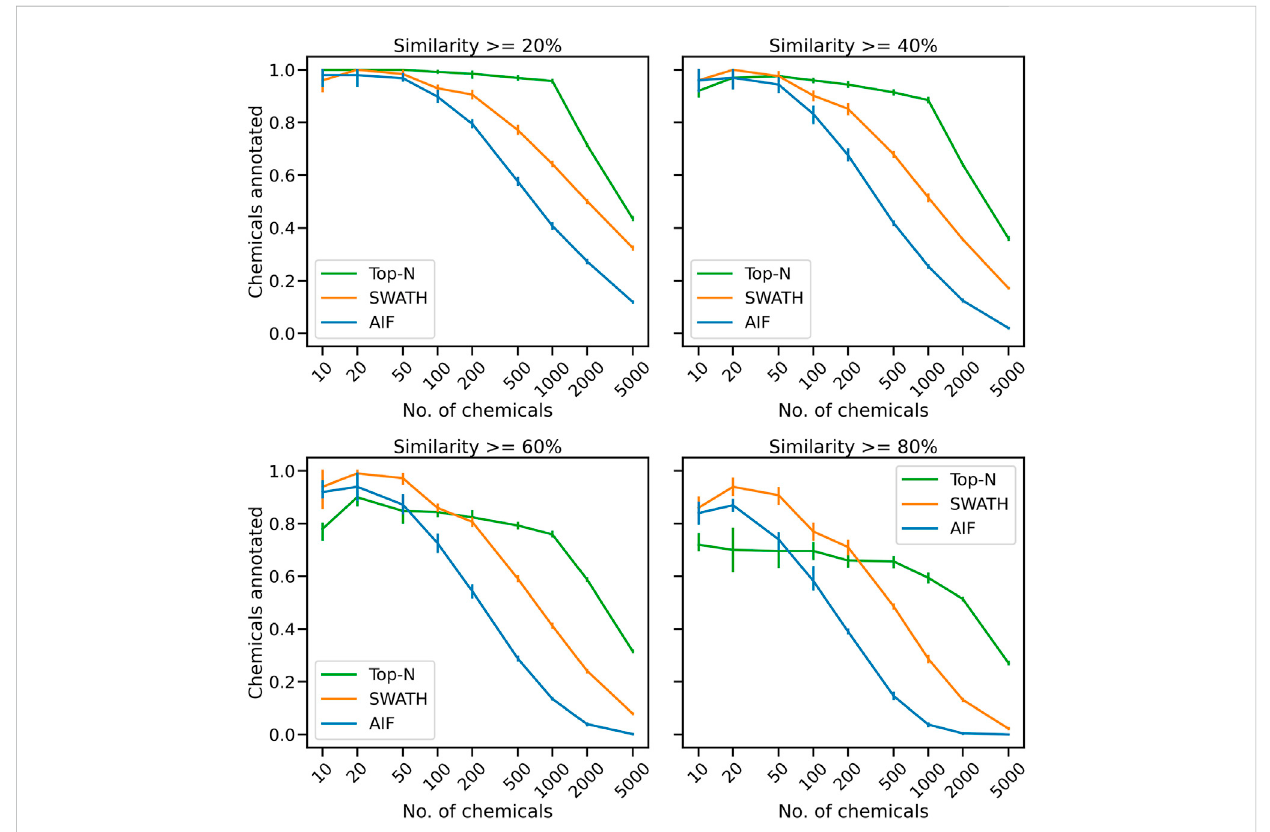
FIGURE 2 The mean proportion of unique chemical annotations at varying numbers of chemicals and similarity thresholds across fi ve replicates. The error bar shows the 95% con fi dence